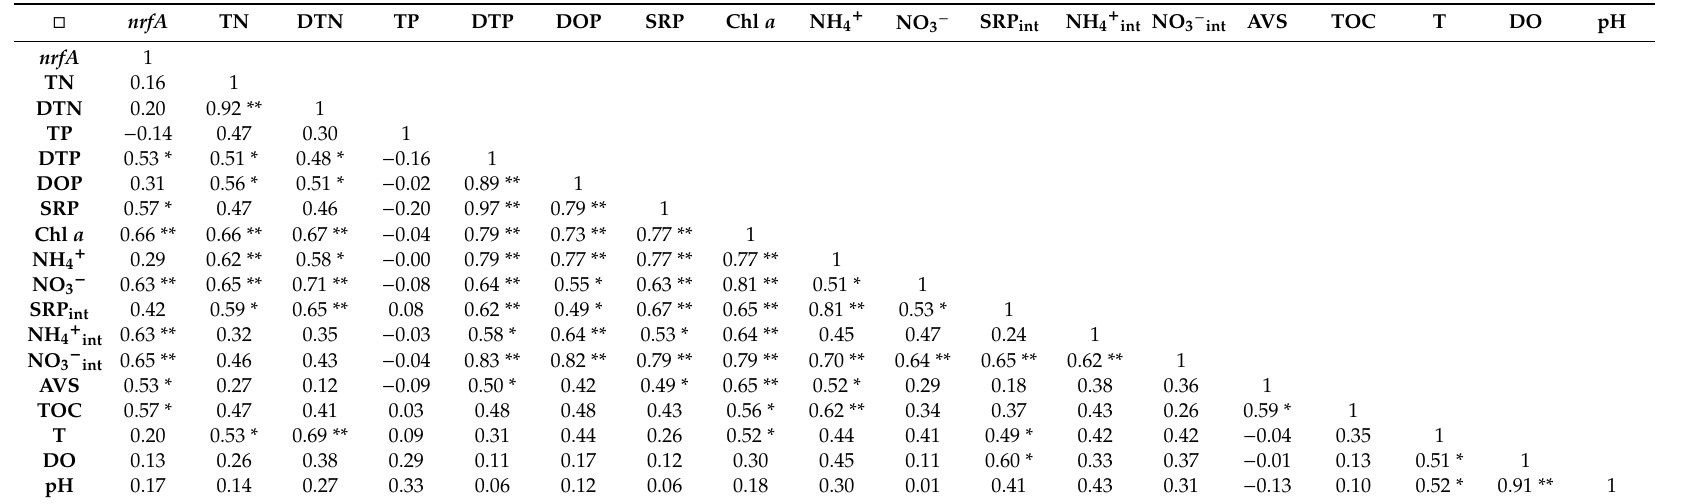
Table 1. Pearson’s correlation coe ffi cients among di ff erent parameters in Lake